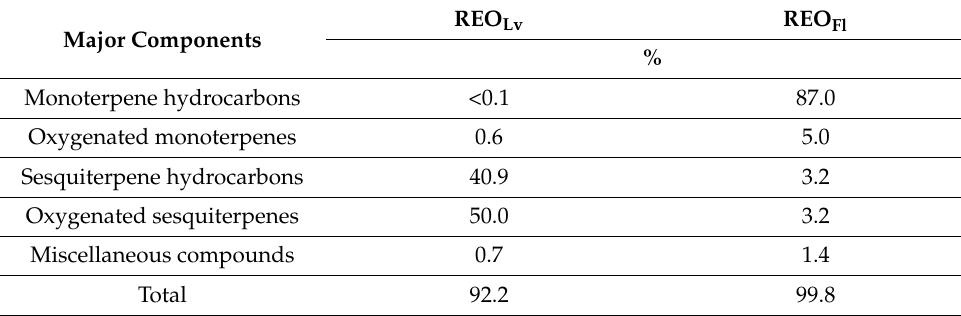
Table 3. Summary of the chemical compositions of R. albiflorum essential